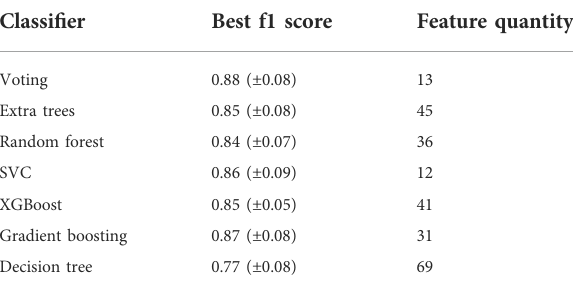
TABLE 3 Best f1 scores and the corresponding number of selected features using distinct classi fi ers models based on the cross- validated